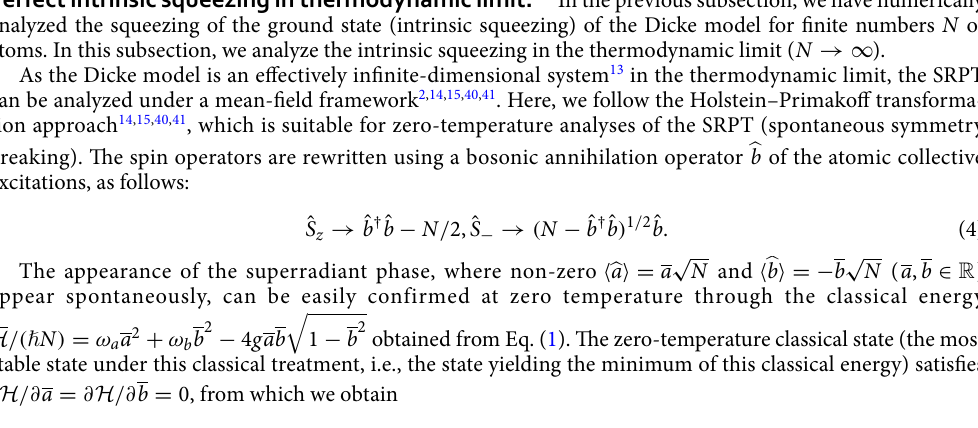
Figure 5. Numerical demonstration of perfect and intrinsic squeezing. ( a–d ) ω b We plot, as a function of g /ω a , ( a, e ) order parameters a and b ; ( b, f ) eigenfrequencies (cid:31) variance; and ( d, h ) optimal angles θ opt , ψ opt , and ϕ opt that yield the minimum variance (� X min ) 2 , indicated by the red bold solid line in Panels c and g. The minimum variance vanishes at the SRPT critical point √ ω a ω b / 2 ), while satisfying the equality in the Heisenberg uncertainty principle � X min � X max ( g = [red dashed line in Panels c and g] with the variance (� X max ) 2 [red bold dash-dotted line in Panels c and g] conjugate to (� X min ) 2